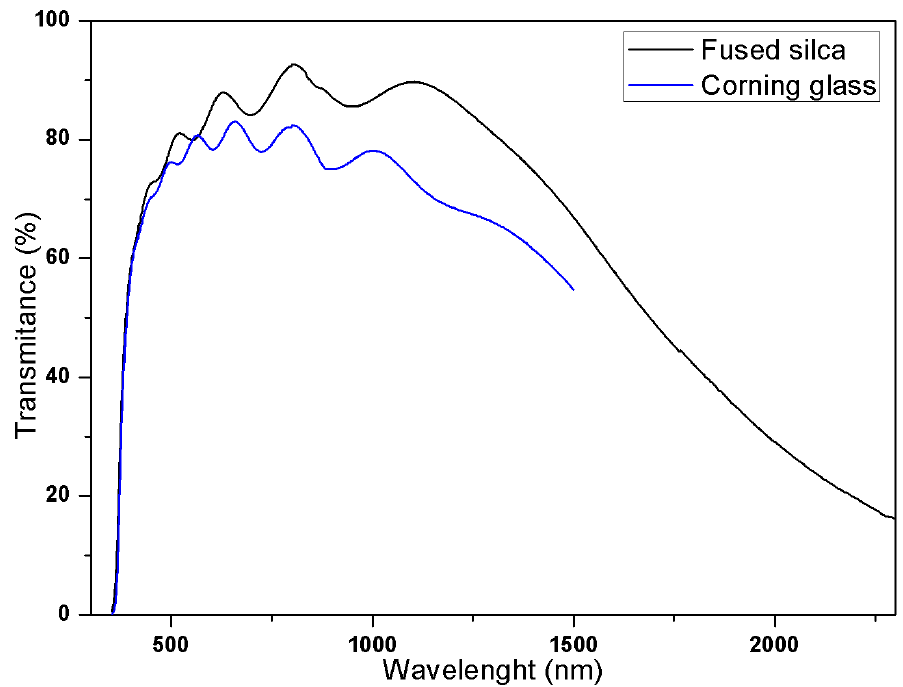
Figure 2. Transmittance spectrum of ZnO:Al thin films deposited on a glass substrate, a fused silica substrate, and a glass substrate. The spectrum exhibited for the fused silica substrate takes a range of wavelengths from 310 nm to 2300 nm, while that of glass only goes from 310 nm to 1500 due to the loss of information produced by the substrate.